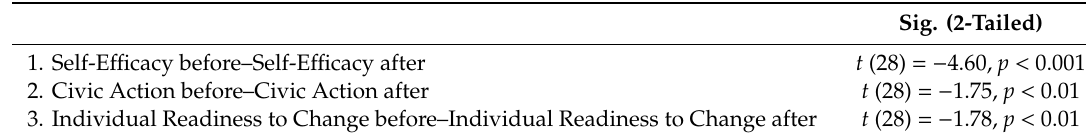
Table 2. Paired samples t